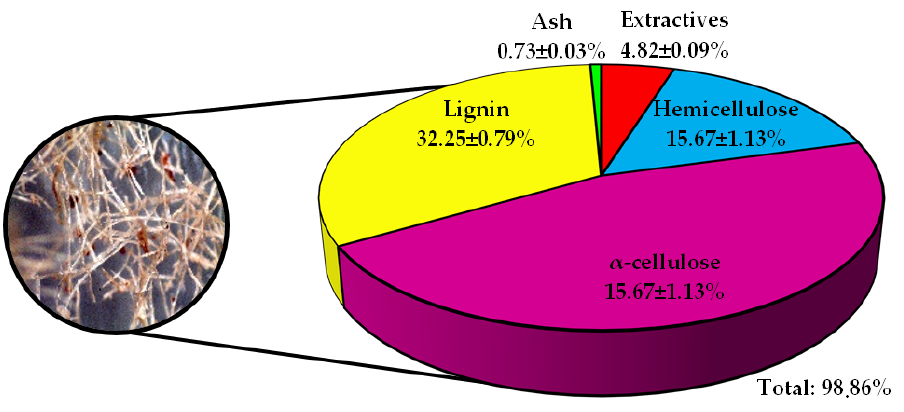
Figure 3. Chemical characterization of the components of the Radiata Pine Thermomechanical Pulp.